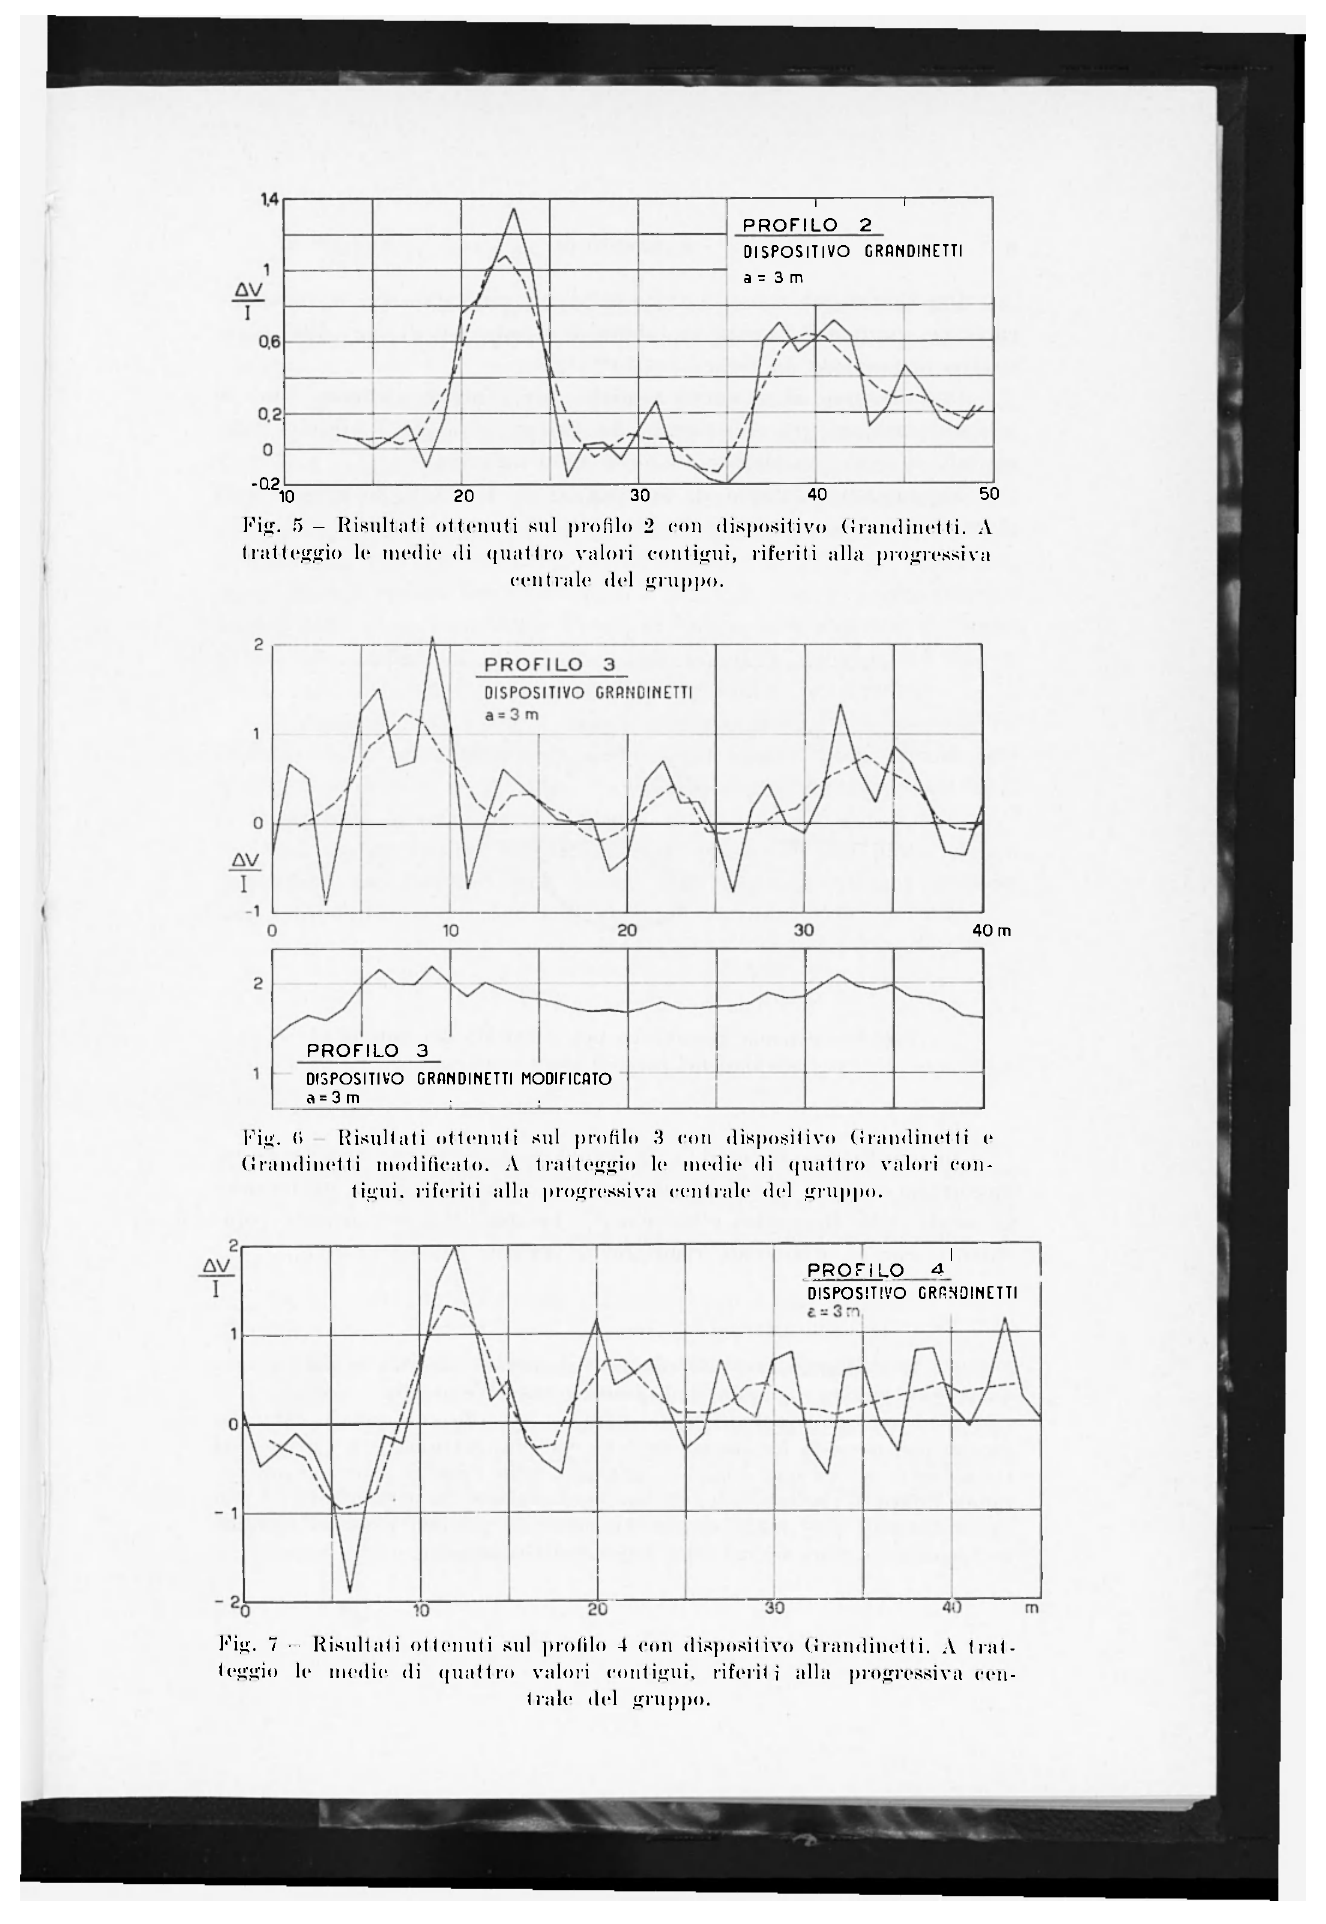
Fig. 7 Risultati ottenuti sul profilo 4 con dispositivo Grandinetti. A trat- teggio le medio di quattro valori contigui, riferiti alla progressiva cen- trale del